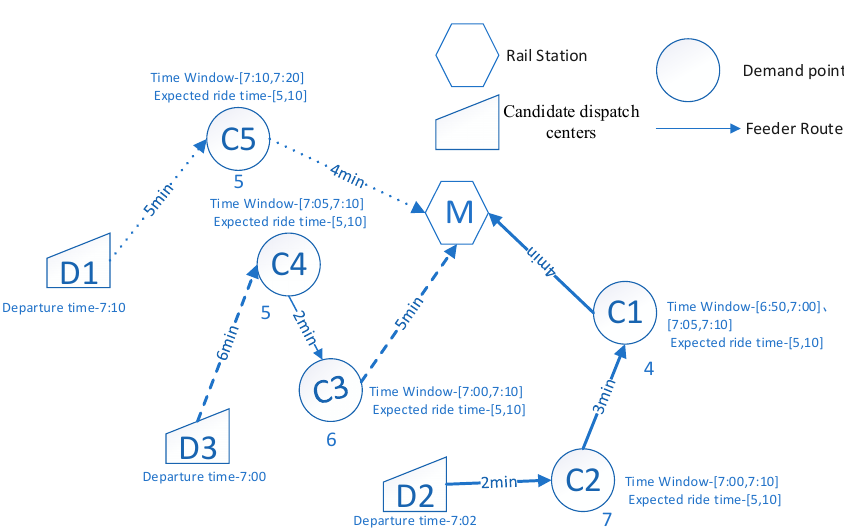
Figure 2. Graphical representation of the integrated DRT problem.